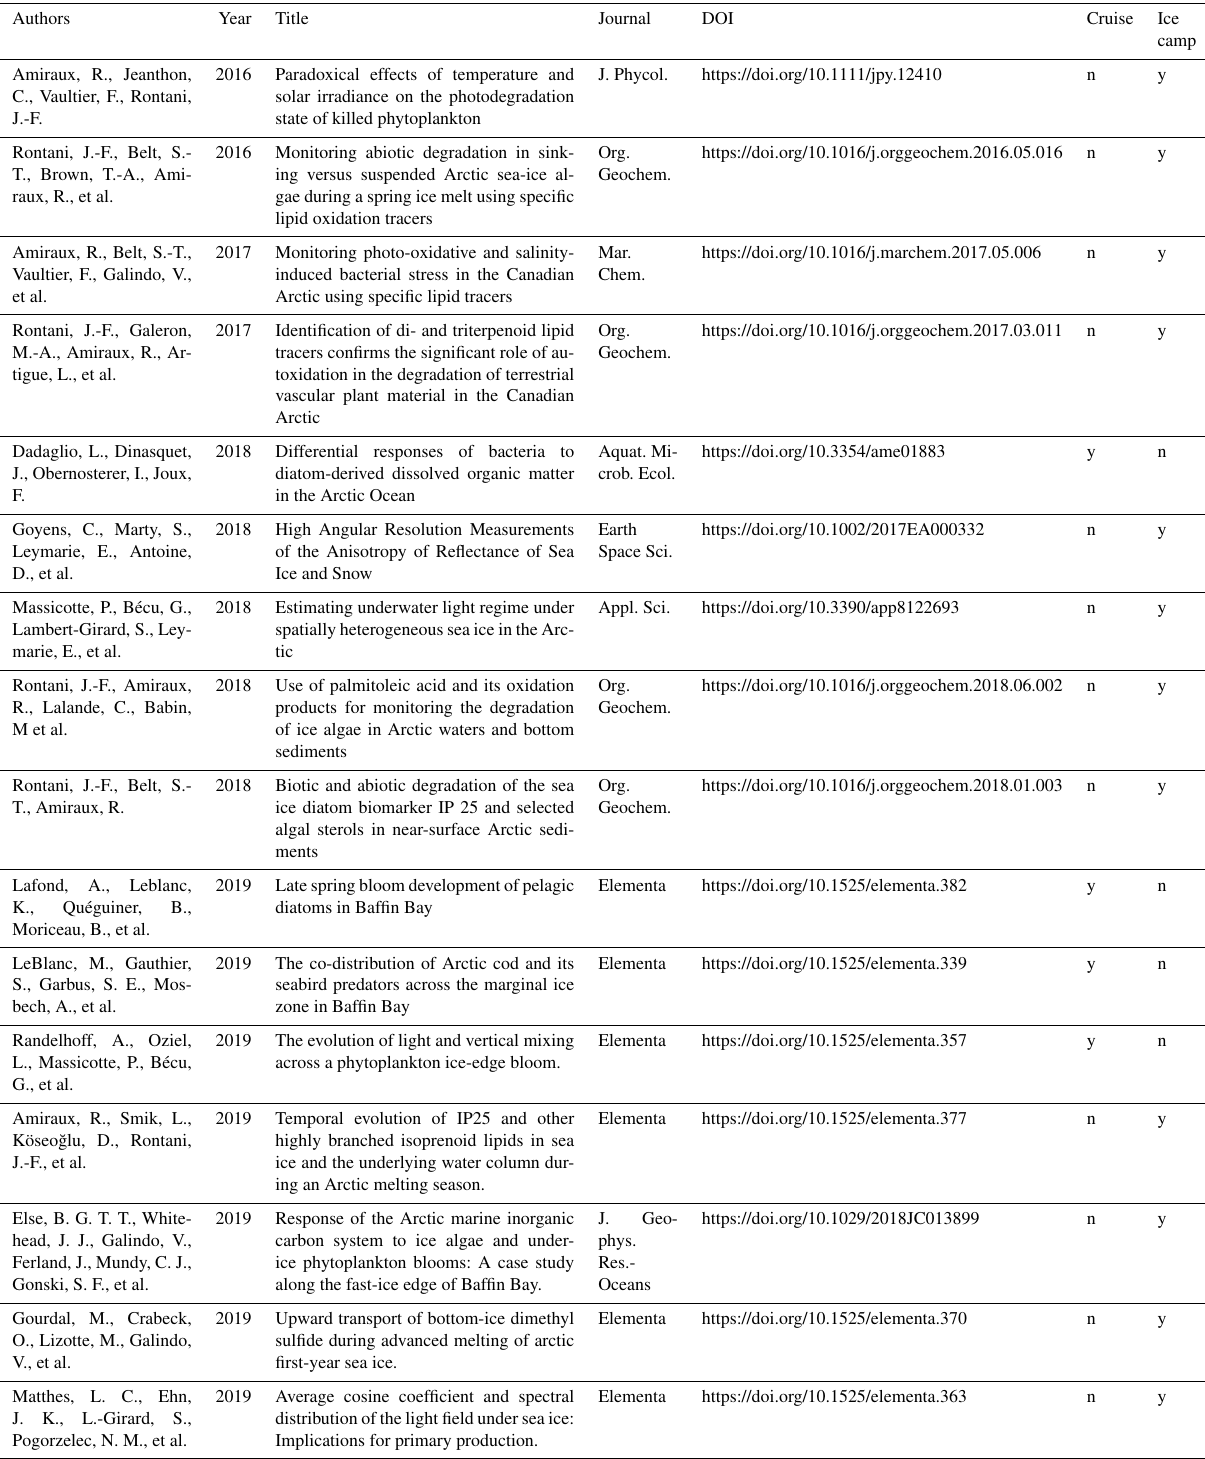
Table 5. List of all peer-reviewed journal articles published so far using Green Edge cruise and/or Green Edge Ice Camp data. Only the first 4 authors are indicated in this